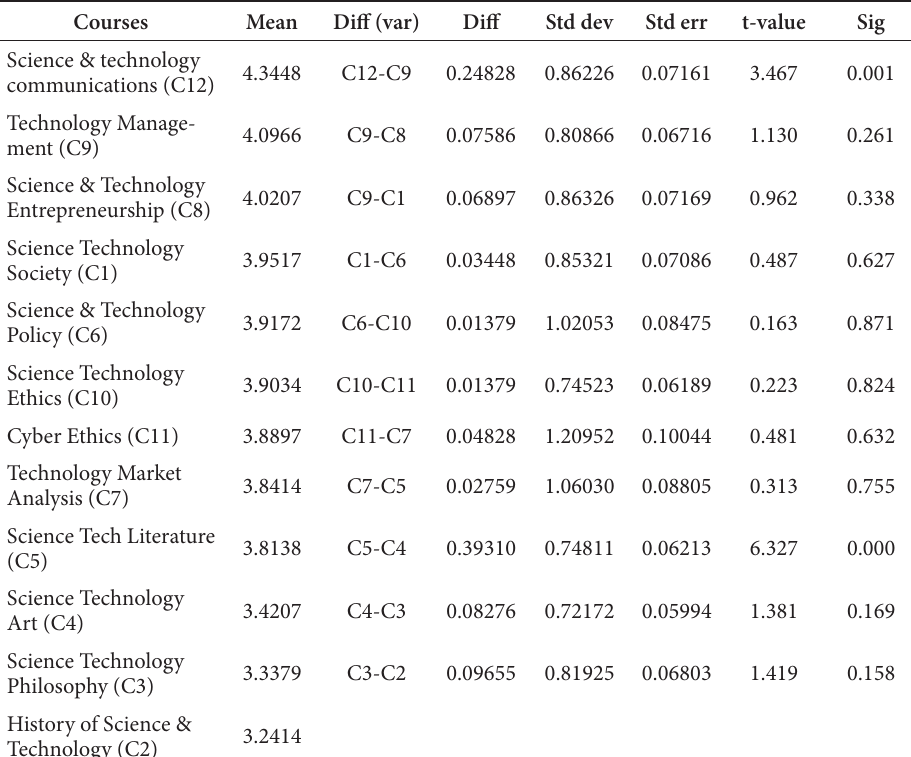
Table 13. Importance ratings of twelve cross-disciplinary courses